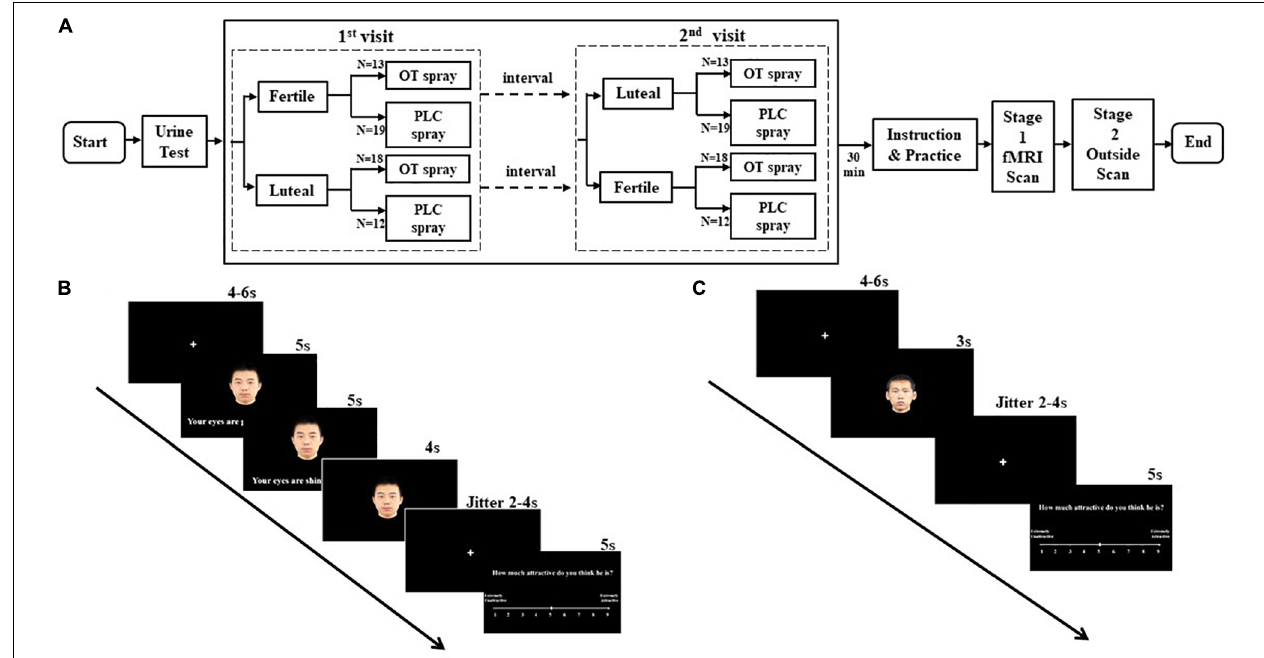
FIGURE 1 | Experiment design. (A) Flow chart of study protocol. (B) A trial of a face paired with a compliment using a conventional metaphor targeting appearance condition (“face + CMA”) during fMRI. (C) A trial presenting a face alone (“face alone” condition) during fMRI. TABLE 2 | Experiment protocol of order a and treatment group on the interval time between two visits and the number of participants. OT group ( N = 31) PLC group ( N = 31) Interval time Number b N N Group